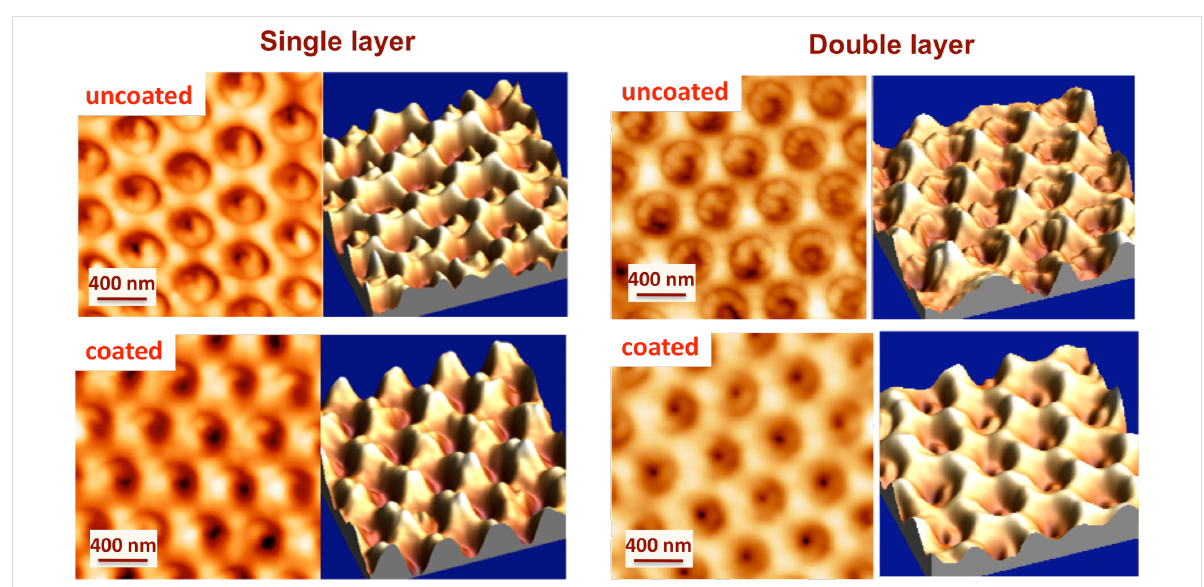
Figure 5: AFM topographies (semi-contact mode) and 3D morphological reconstruction of typical plasmonic structures before and after coating with a single layer of ≈ 6 nm (left) and a double layer (right) of silica. The coatings were realized by using 1:6 (v/v) EtOH dilution of the starting sol (pH ≈ 4) at a withdrawal speed of 50